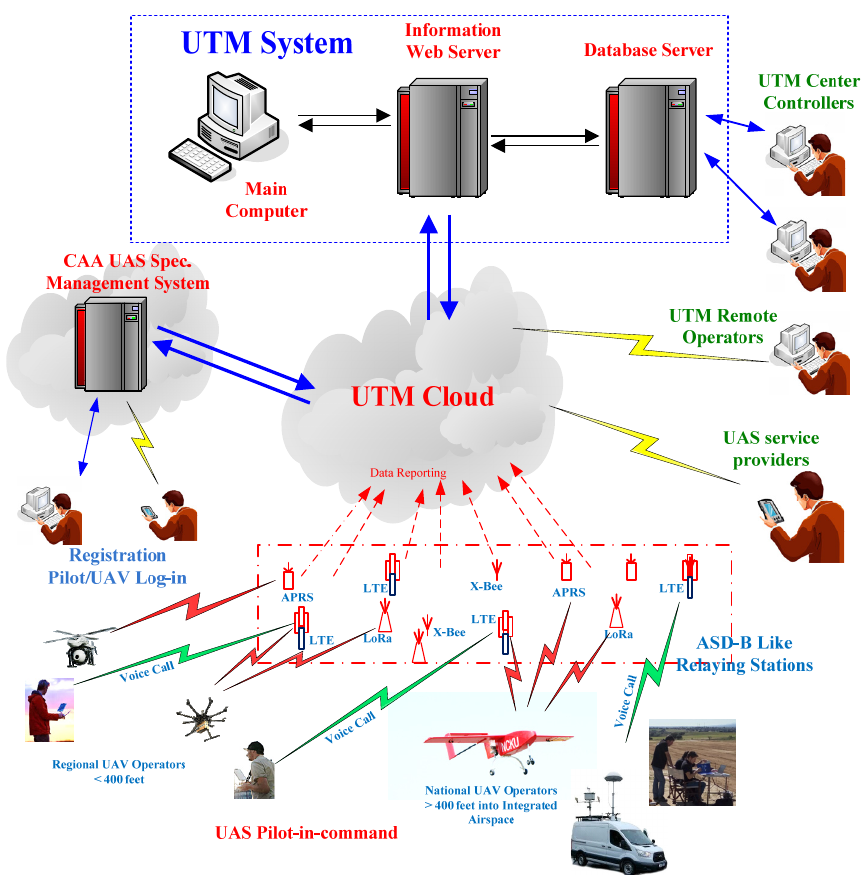
Figure 5. The proposed hierarchical UTM system.